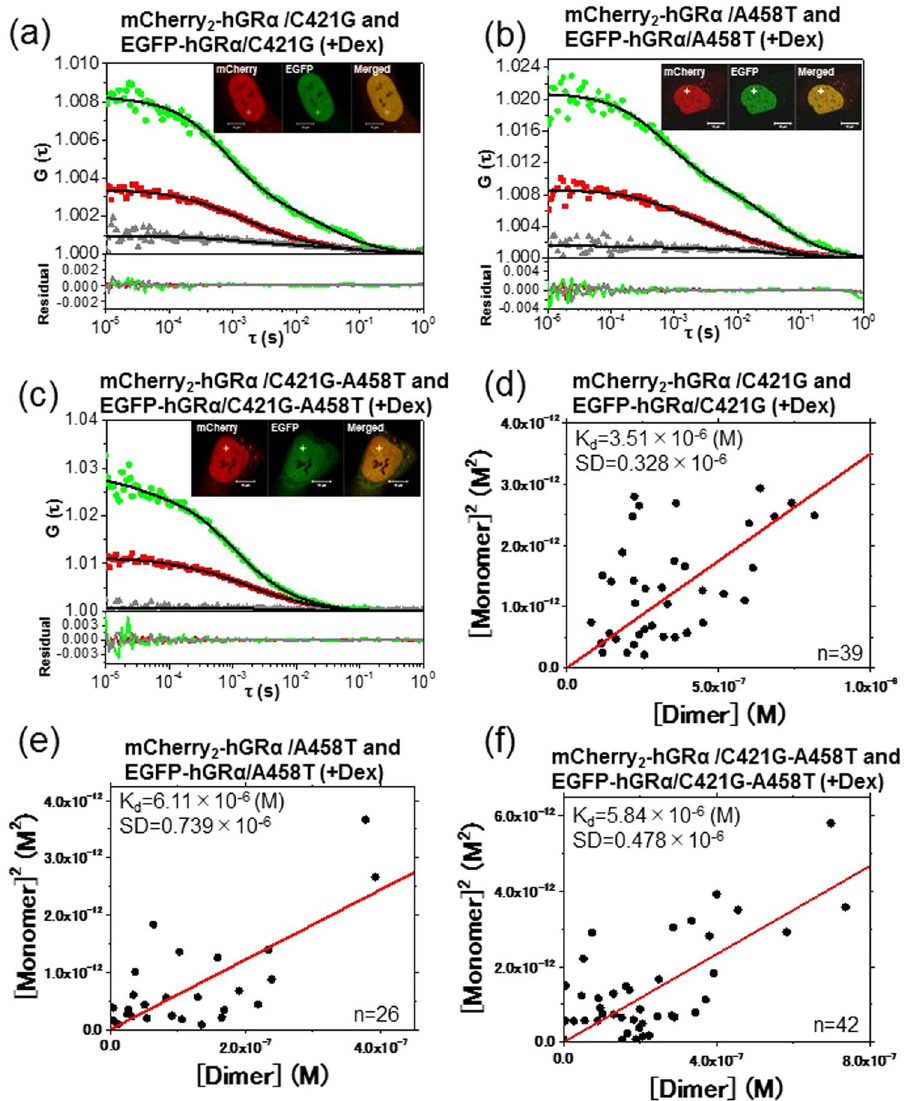
Figure 5. FCCS and K d analysis of GR α mutants. Typical auto- and cross-correlation curves obtained from U2OS cells coexpressing the pairs of chimeric fusion proteins after addition of the ligand. The filled green diamonds, red squares, and gray triangles denote autocorrelation of the green channel [ G G ( τ )], autocorrelation of the red channel [ G R ( τ )], and cross-correlation curve [ G C ( τ )], respectively, with their fits (solid black lines) and residuals. The insets show LSM images of U2OS cells coexpressing the pairs of chimeric fusion proteins. FCCS analyses were performed in the nucleus, which is indicated by the white crosshairs. The scale bars are 10 μ m. FCCS was conducted on U2OS cells coexpressing ( a ) mCherry α / C421G and EGFP-hGR α / C421G, 2 -hGR ( b ) mCherry 2 -hGR α / A458T and EGFP-hGR α / A458T, or ( c ) mCherry 2 -hGR α / C421G-A458T and EGFP- hGR α / C421G-A458T 20 min after addition of 100 nM Dex. ( d,e,f ) Results of K d determination using scatter plots and linear regression. The plots represent the square of the concentration of the monomeric hGR α versus the concentrations of the dimer of hGR α . The solid lines show the linear fit. The slope indicates K d . ( d ) mCherry 2 -hGR α /C421G and EGFP-hGR α /C421G after addition of Dex. ( e ) mCherry 2 -hGR α /A458T and EGFP-hGR α /A458T after addition of Dex. ( f ) mCherry 2 -hGR α /C421G-A458T and EGFP-hGR α /C421G- A458T after addition of